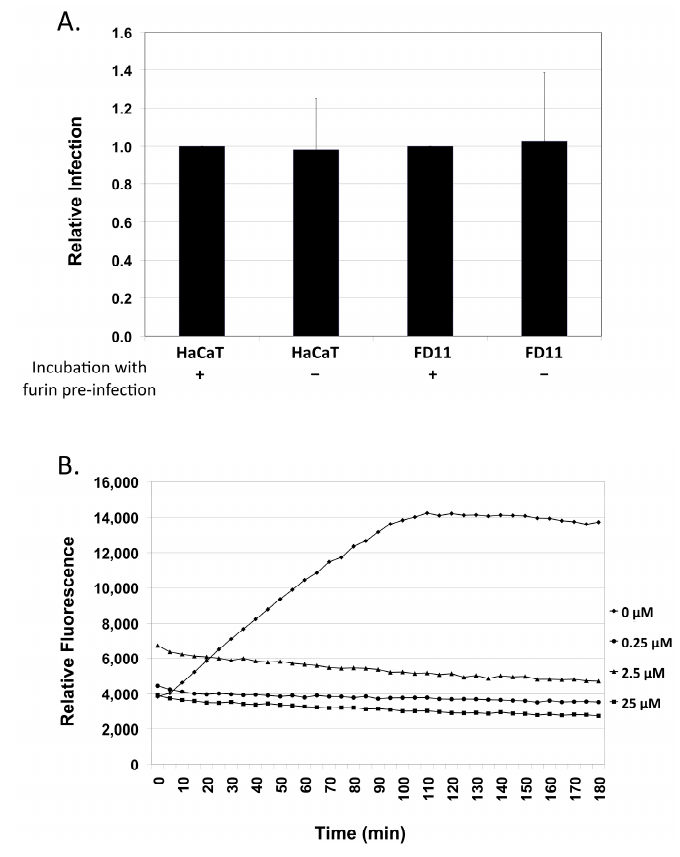
Figure 3. Addition of exogenous furin prior to infection has no effect on infectivity. ( A ) Infection of HaCaT cells and furin-negative CHO FD11 cells after incubating the virus for 7 h at 37 °C with 5U exogenous furin enzyme. Infections were analyzed by RT-qPCR measuring the relative amount of E1^E4 transcript two days post-infection normalizing to virus infections not treated with exogenous furin; ( B ) Cleavage of the Boc-Arg-Val-Arg-Arg-AMC fluorogenic peptide at increasing concentration (0, 0.25, 2.5 and 25 µM) of furin inhibitor in virus 0.05 M phosphate buffer. Fluorescence was recorded at Ex/Em 350/450. The results are expressed as the means of at least three independent infections utilizing at least two different virus preps and standard deviations are shown. Statistical significance (denoted by asterisks) was determined by student’s t -test and significance was defined as p ≤ 0.05.